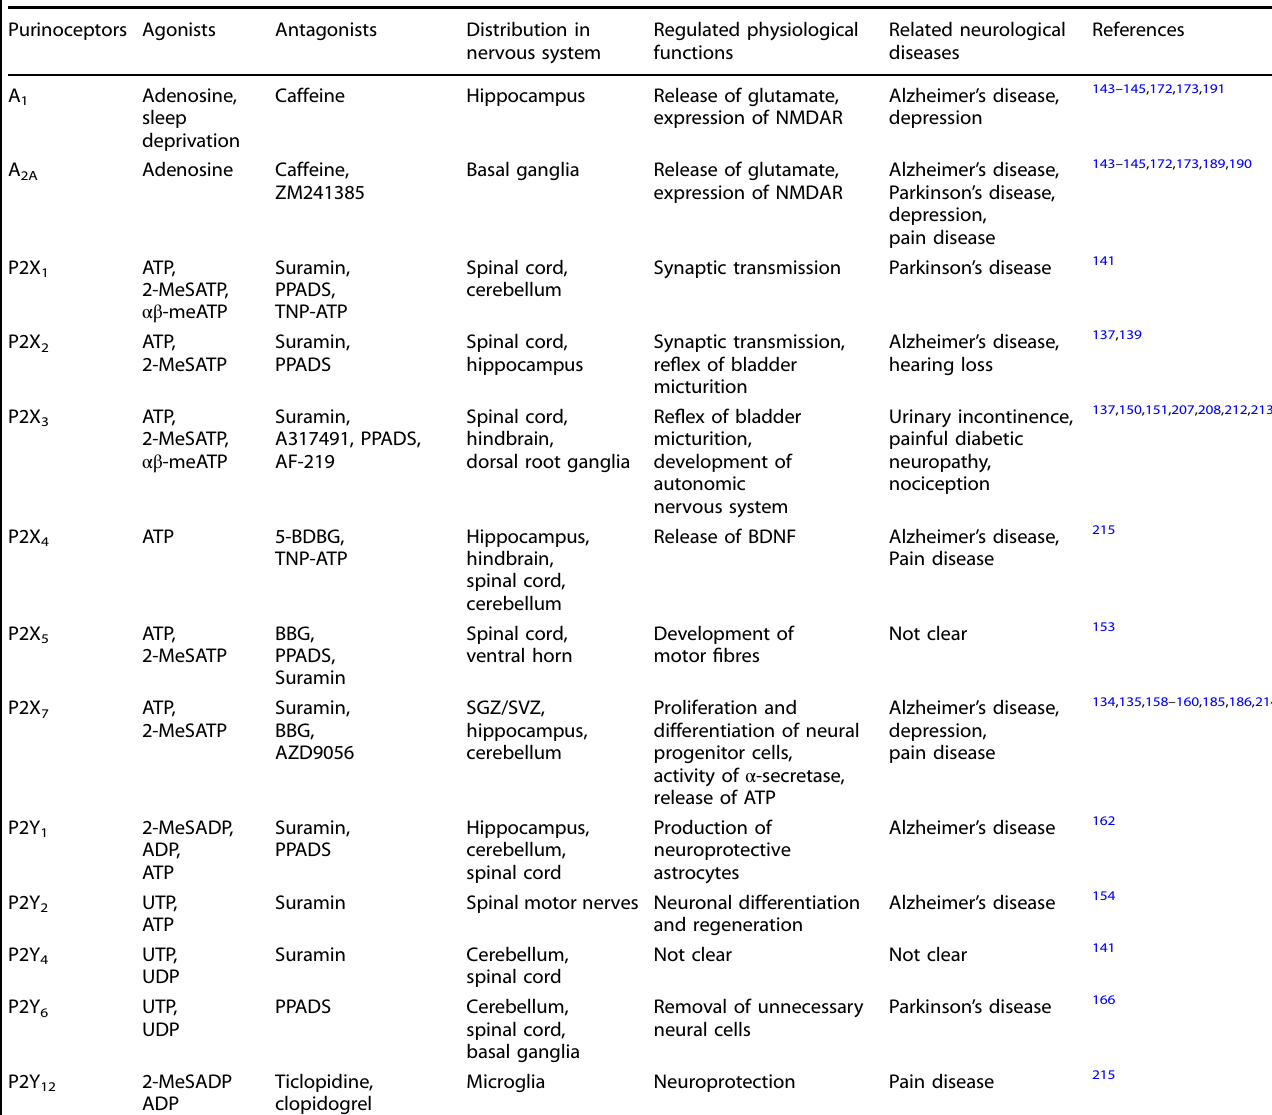
Table 1. Several purinoceptors and their effects in neurotransmission in neurological diseases Purinoceptors